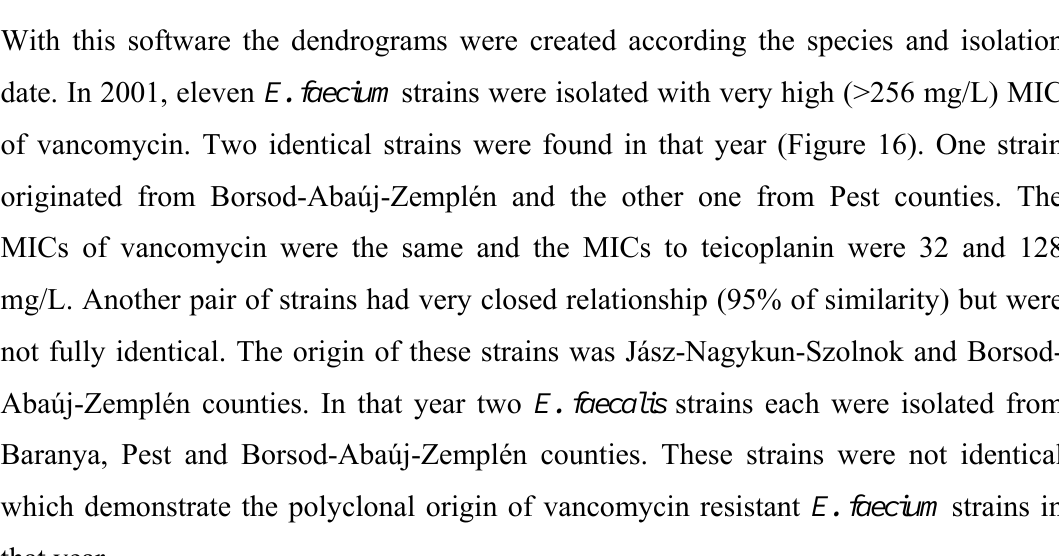
Figure 15. A representative PFGE gel of the VRE